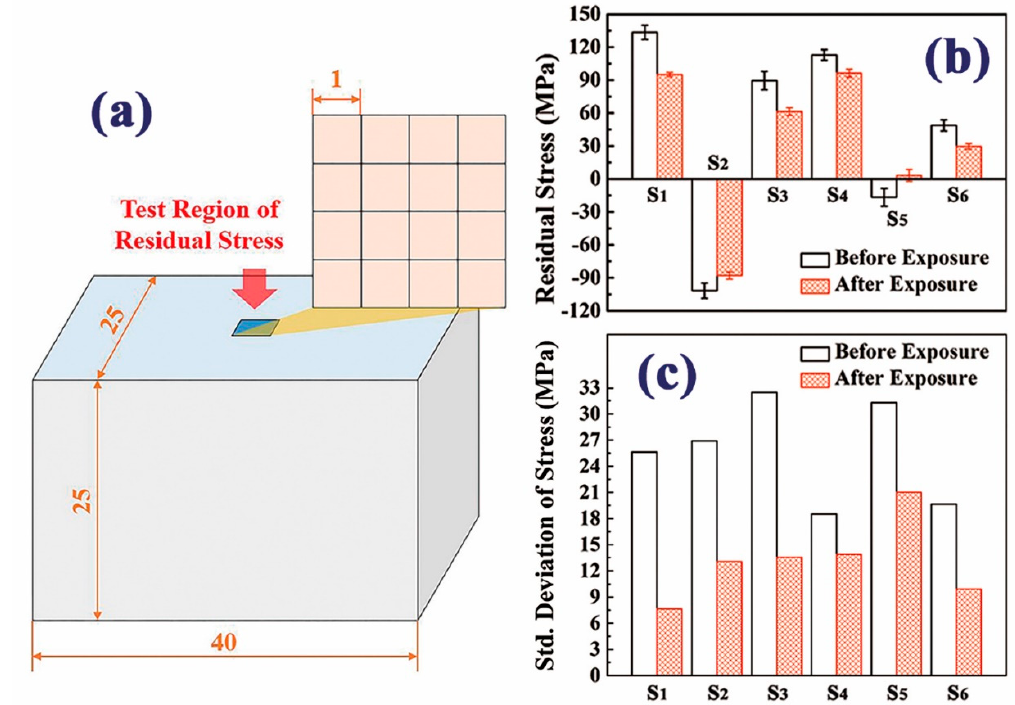
Figure 4. ( a ) The diagram of the test region of each residual stress specimen; ( b ) the residual stress values of each specimen’s test region before and after magnetic exposure, where the error bars represent the standard errors which are determined by (cid:3495)∑ (cid:4666)𝜎 (cid:3036) − 𝜎(cid:3364)(cid:4667) (cid:2870)(cid:2869)(cid:2874) (cid:3036)(cid:2880)(cid:2869) (cid:4666)15 × 16(cid:4667)⁄ ; ( c ) the standard deviations of the stress test values of each specimen’s test region before and after magnetic exposure, which are determined by (cid:3495)∑ (cid:4666)𝜎 (cid:3036) − 𝜎(cid:3364)(cid:4667) (cid:2870)(cid:2869)(cid:2874) (cid:3036)(cid:2880)(cid:2869) 16⁄ .